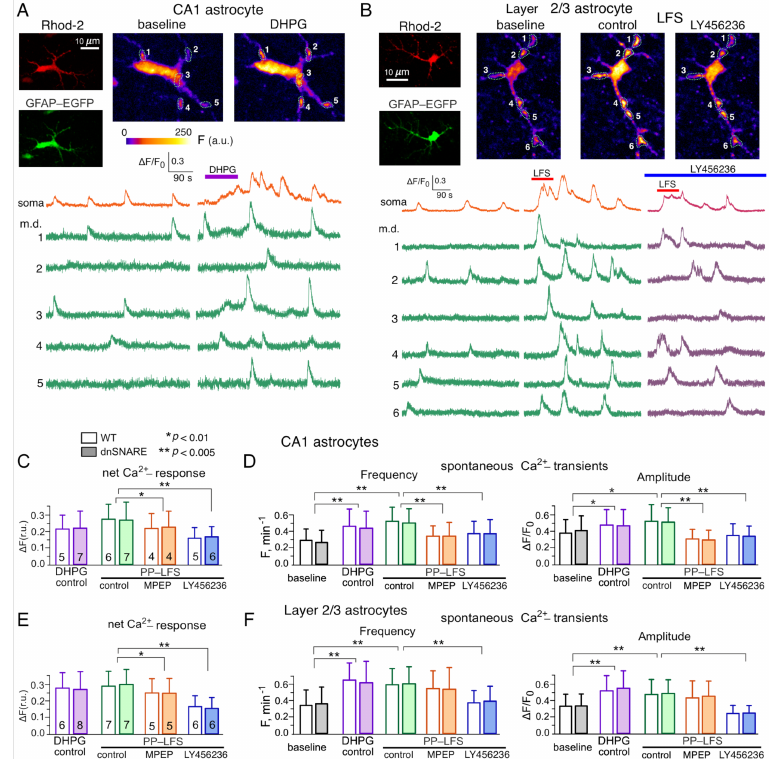
Figure 1. mGluR-receptors contribute to Ca 2+ -signalling in hippocampal and neocortical astrocytes. ( A ) Representative multi-photon images of EGFP fluorescence and presudo-color images of Rhod-2 fluorescence recorded in the astrocytes of dnSNARE mice before (baseline) and after the applica- tion of Group I amGluR agonist DHPG. Examples of Ca 2+ -transients recorded in the soma and microdomain (m.d.) ROIs indicated in the images are shown below. Note the marked increase in the spontaneous Ca 2+ -elevations after application of DHPG. ( B ) representative multi-photon images and Ca 2+ -transients recorded in the layer 2/3 astrocyte before (baseline) and after 2 min-long episode of paired-pulse low-frequency stimulation (LFS) of cortical afferents in control and in the presence of mGluR1 antagonist LY456236. Note the significant enhancement of spontaneous Ca 2+ -signalling after stimulation in the control and inhibitory effect of LY456236. ( C – F ) The pooled data on the net cell responses to DHPG and LFS ( C , E ) and amplitude and frequency of the baseline spontaneous Ca 2+ - transients ( D , F ) recorded in the CA1 ( C , D ) and layer 2/3 ( E , F ) astrocytes of WT and dnSNARE mice in control and in presence of mGluR antagonists. The data are shown as mean ± SD for the number of cells indicated in the panels ( C , E ). Asterisks (*,**) indicate the statistical significance of effects of DHPG and mGluR antagonists according the multi-variant ANOVA. Note the lack of difference in the parameters of Ca 2+ -signaling between WT and dnSNARE mice and sensitivity of CA1 and layer 2/3 astrocytes to mGluR